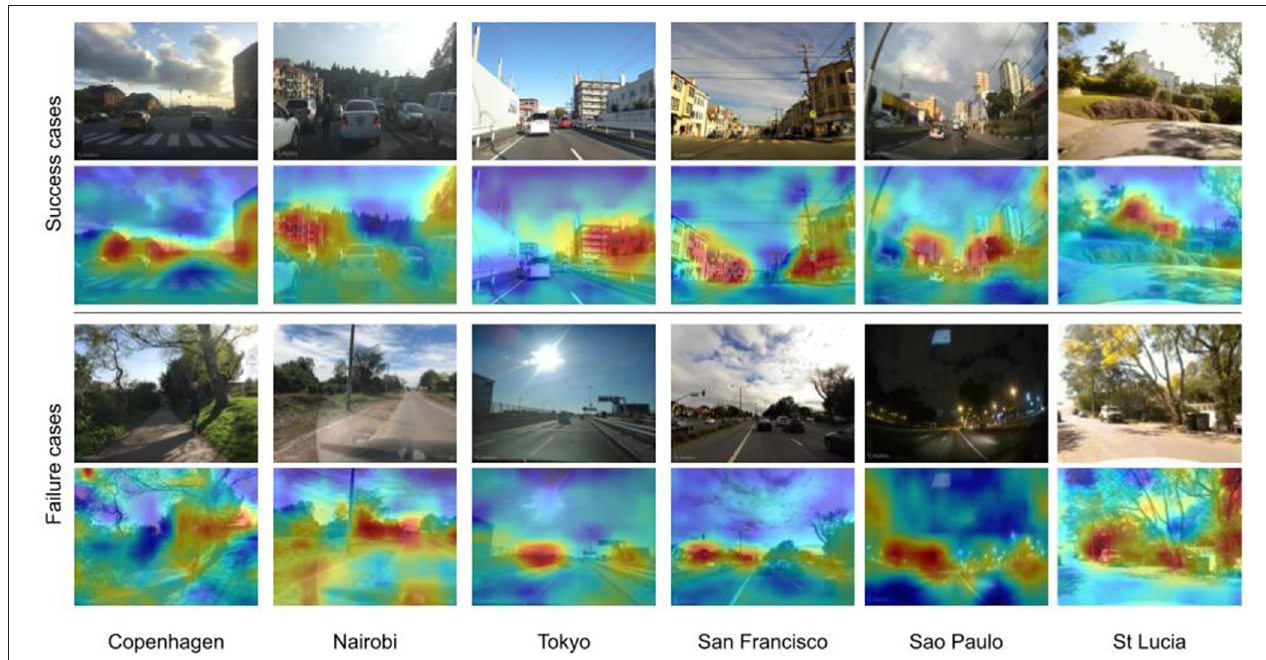
FIGURE 6 | Domain generalization qualitative results: top-half rows depict the queries and their associated attention map, which are successfully geolocalized in the first prediction. Bottom-half rows show failure cases which are not retrieved even after 20 predictions.